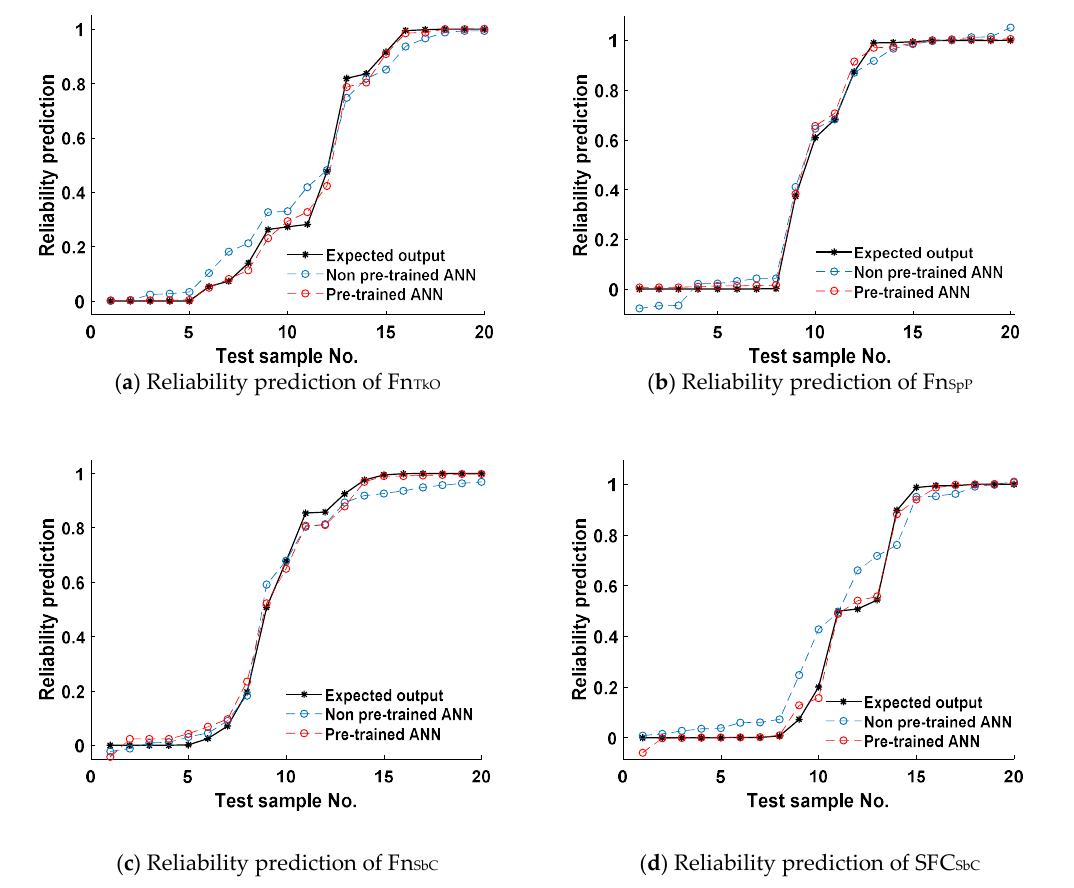
Figure 9. Prediction comparison of the ANN and pre-trained ANN.